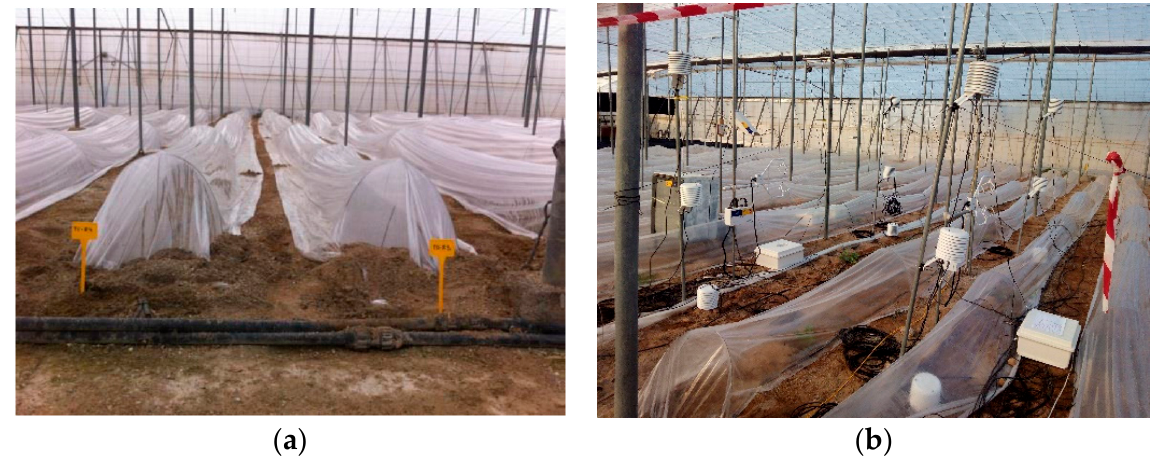
Figure 1. Low tunnels installed inside the experimental greenhouse ( a ) and measurement equipment ( b ).